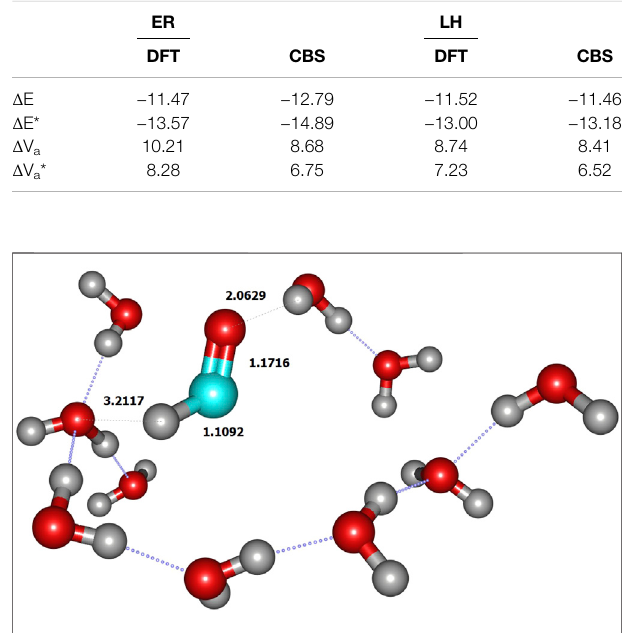
FIGURE 4 | Product geometry (limited to QM